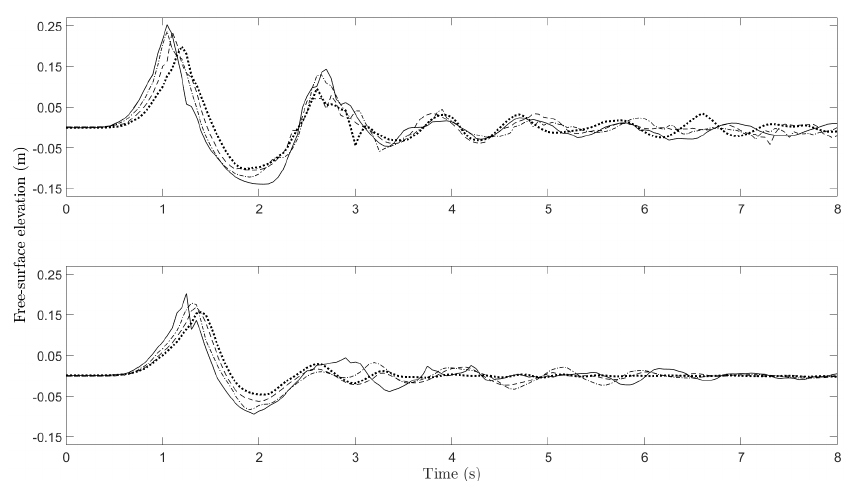
Figure 11. Records of free-surface elevation at x = 1 m. ( Top ) Results for Case 00 (solid line); Case 01 (dash-dotted line); Case 02 (dashed line); and Case 03 (dotted line). ( Bottom ) Results for Case 04 (solid line); Case 05 (dash-dotted line); Case 06 (dashed line); and Case 07 (dotted line).